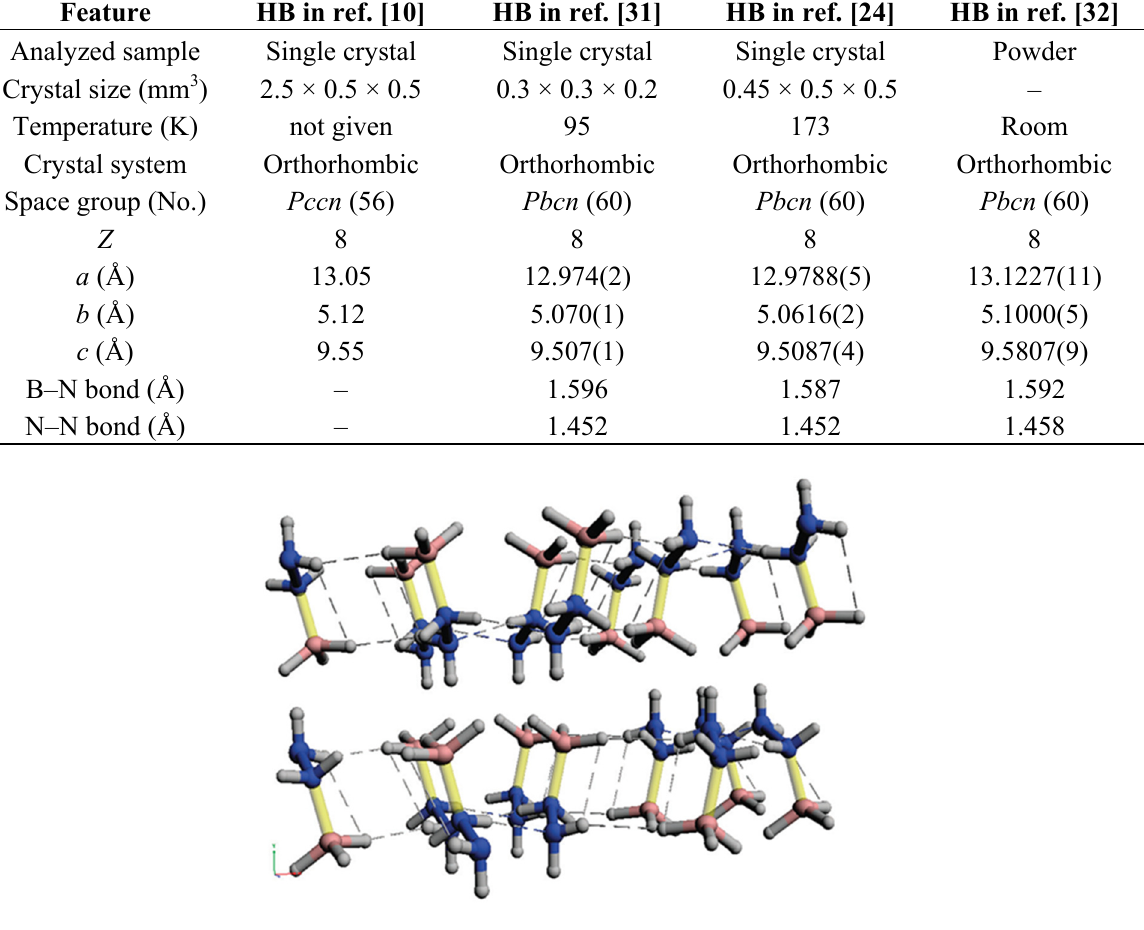
Figure 2. Head-to-tail network of the hydrazine borane molecules N 2 H 4 BH 3 determined from XRD data [24]—Reproduced by permission by the PCCP Owner Societies. The red arrow indicates the x axis and the green one the y axis. The intermolecular interactions are shown by the grey dashed